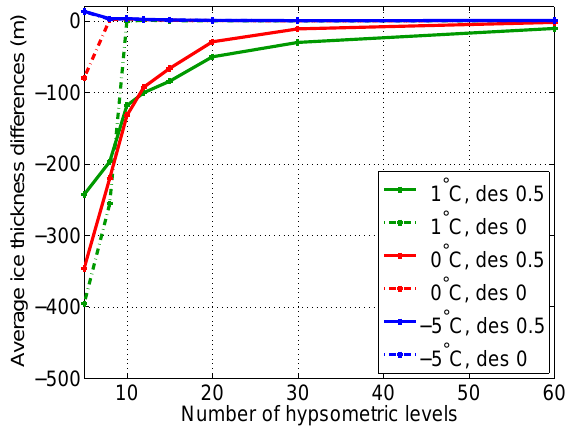
Figure 3. SG model vs. ISSM differences over an idealized in- clined plane terrain. Average ice thickness differences (SG model − ISSM) are presented for simulations using different temperatures, desertification effect factors and number of hypsometric